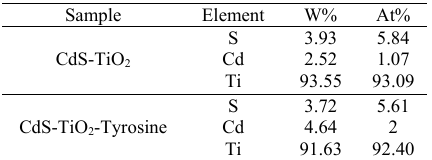
Table 2. Elemental Analysis of photocatalysts (CdS-TiO 2 and CdS-TiO 2 -Tyrosine)